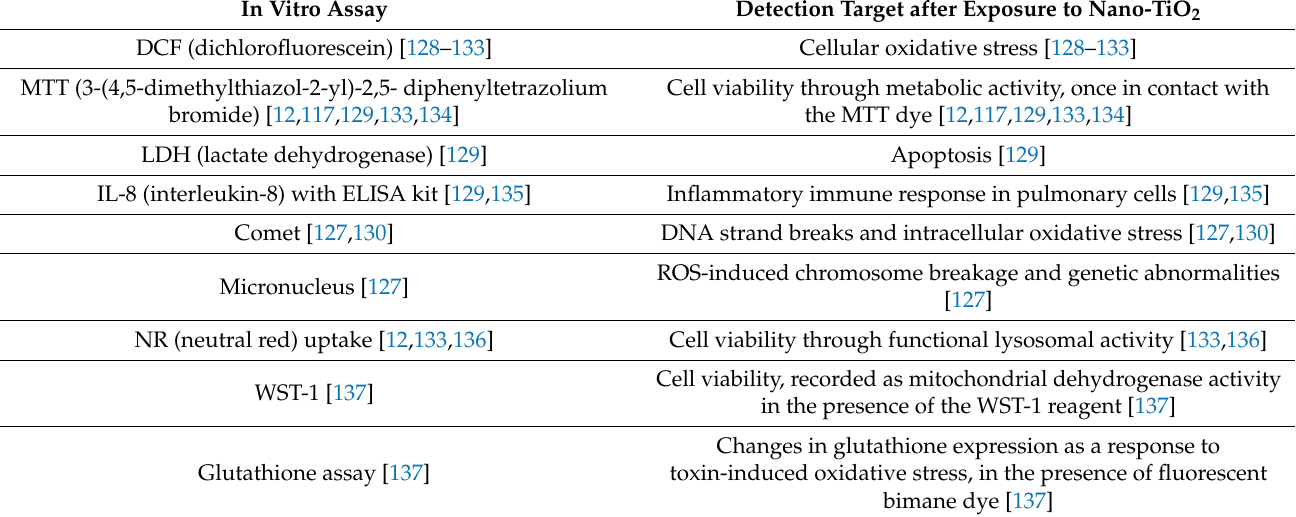
Table 2. In vitro toxicity assays for TiO 2